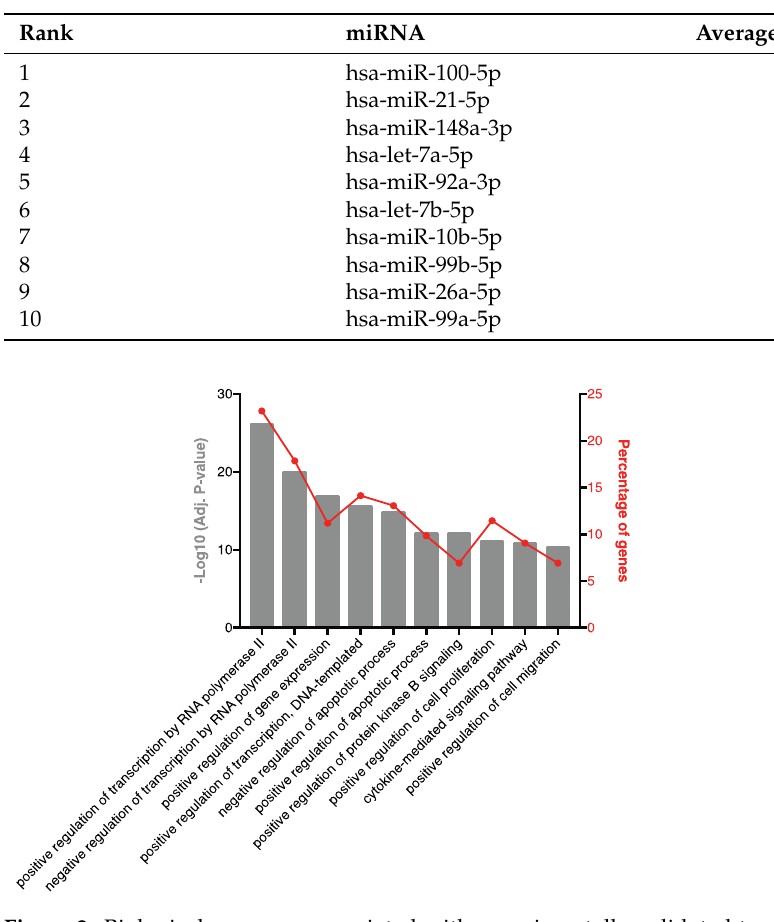
Table 3. Common targets of the 10 highest-ranked EV miRNAs.